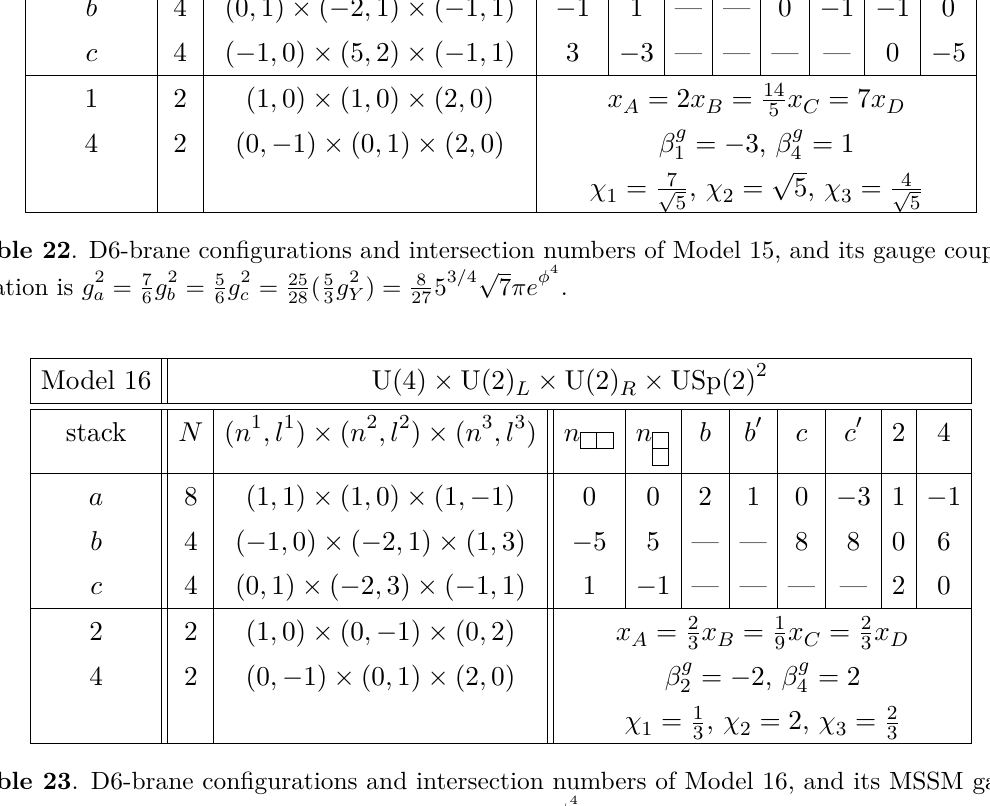
4 = 18 g 2 = 2 g 2 = 10 ( 5 g 2 ) = 24 πe φ a b c Y 5 7 3 5